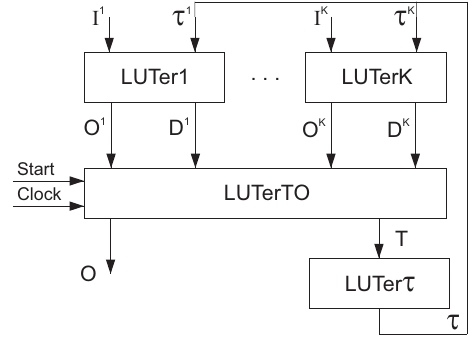
Figure 25. Structural diagram of P T Mealy FSM.